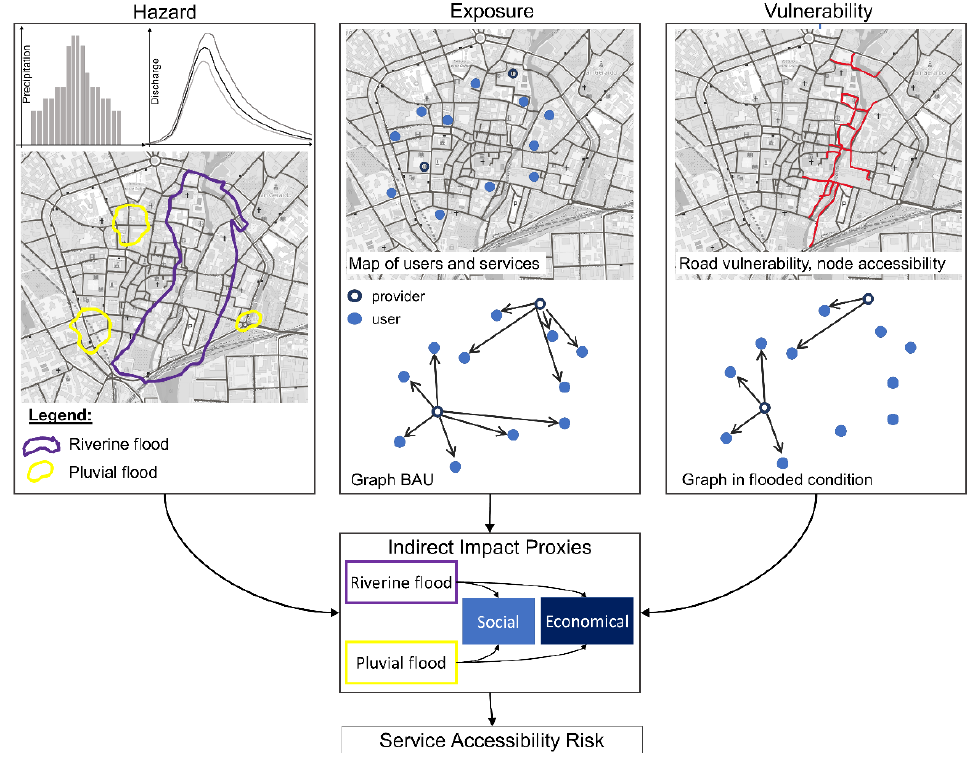
Figure 1. SAR methodological framework.